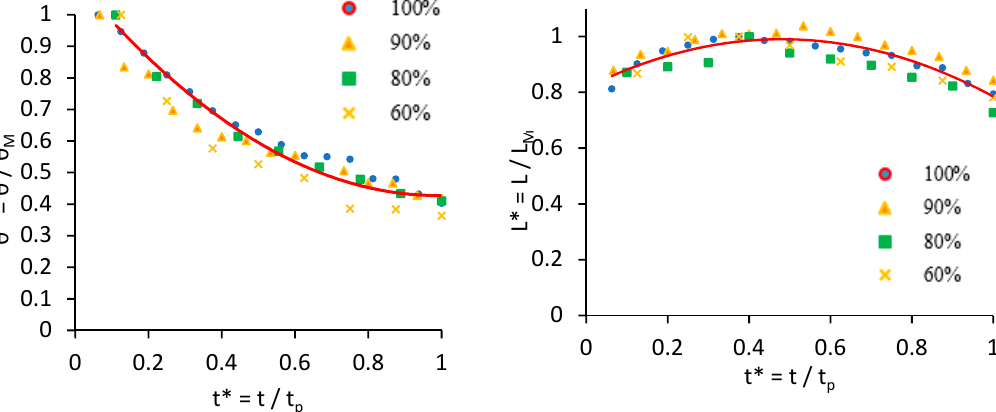
Figure 8. Contact angle and droplet base diameter dimensionless profiles for di ff erent concentrations of surfactant on dry dishwasher sponge [7].